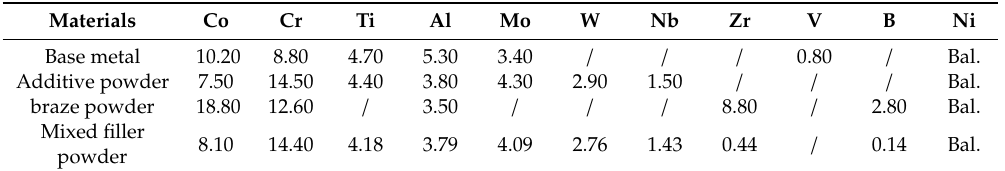
Table 1. Chemical compositions (in wt.%) of the base metal, additive powder, braze powder, and mixed filler